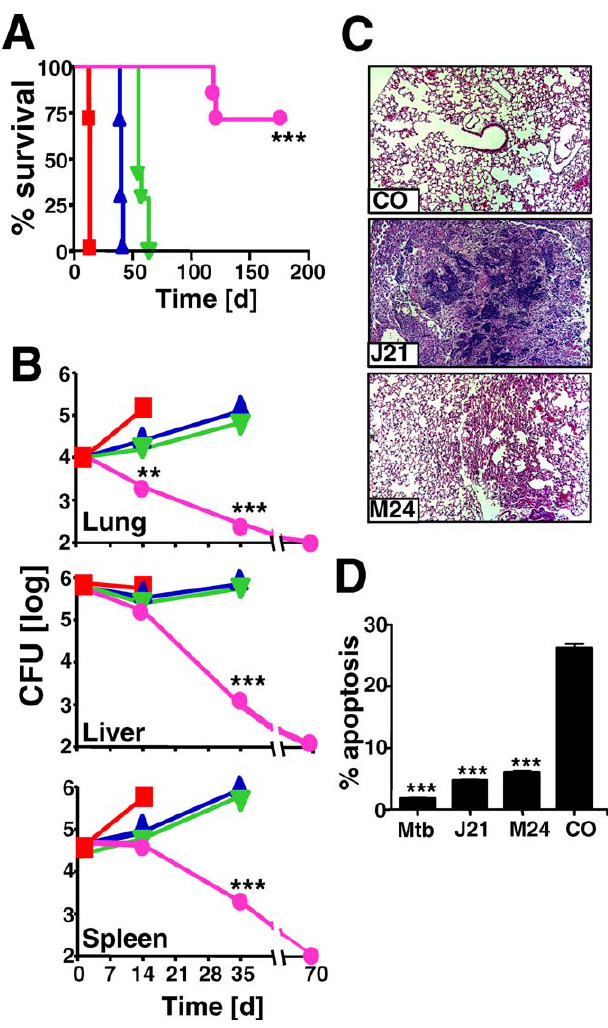
Figure 2. Correlation between Apoptosis Inhibition and Mycobacterial Virulence (A and B) SCID mice were infected intravenously with 10 6 bacteria and survival ([A], n ¼ 7 per group), or the bacterial load in lung, liver, and spleen ([B], n ¼ 3 per time point), were determined. Shown are results with Mtb (squares), Mkan-J21 (triangle), Mkan-M24 (inverted triangle), and Mkan-CO (circle). (C) Histopathology (hematoxylin and eosin staining) of lungs from SCID mice infected 5 wk earlier with Mkan-CO, Mkan-J21, or Mkan-M24 as indicated. (D) Levels of apoptosis in vivo after 2 wk of infection were determined by quantification of TUNEL-positive cells per total cell nuclei in lung tissue sections. Means 6 SD for blinded analysis of about 2,000 total cells per tissue section (three sections per lung) per mouse ( n ¼ 3) are shown. The results shown are representative of three independent experiments. Error bars representing 6 SD are shown in (D) and are smaller than symbols in (B). Asterisks indicate p -values as in Figure